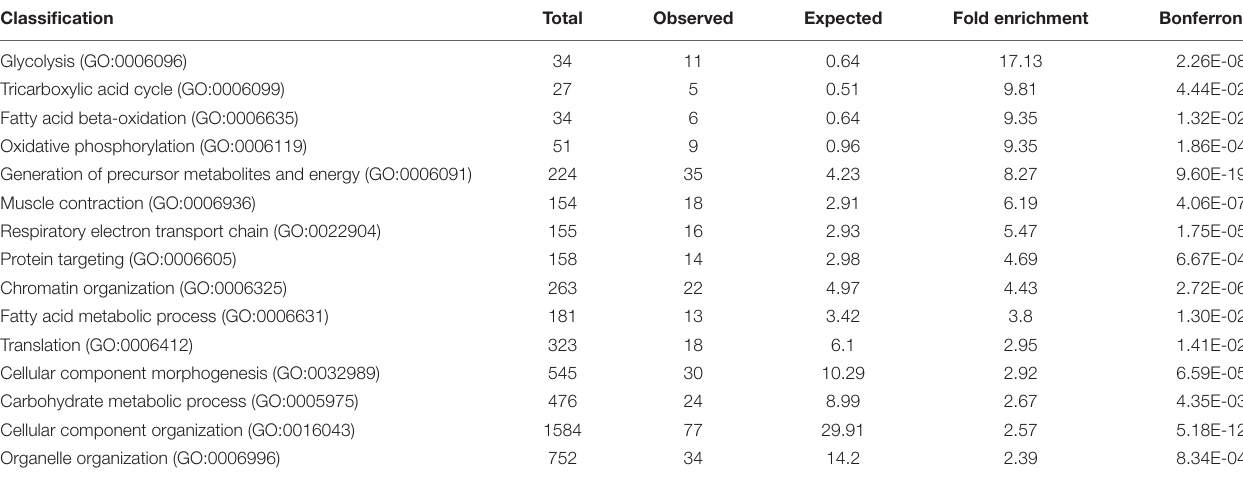
TABLE 3 | GO classifications of proteins differing in abundance between lean and obese muscle. Classification Total